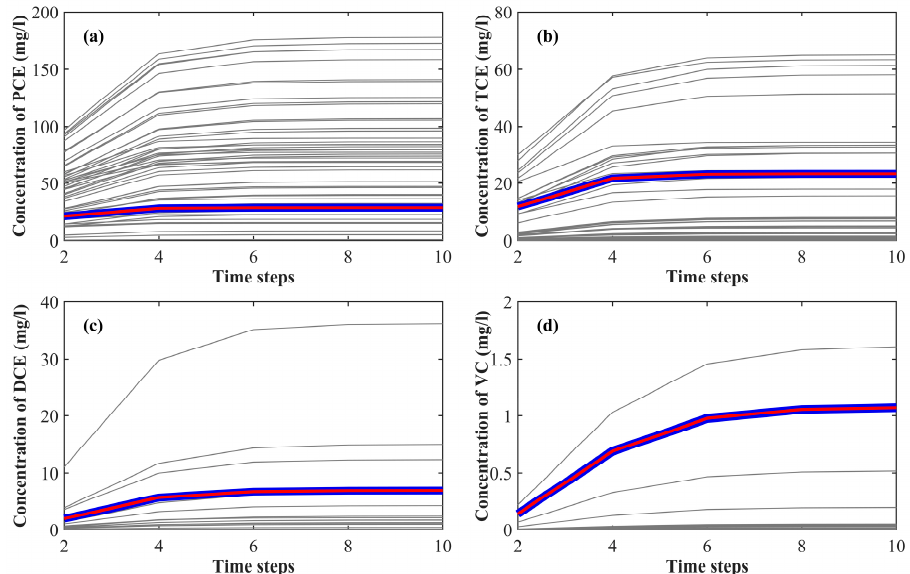
Figure 5. The performance of data match. ( a ), ( b ), ( c ), ( d ) shows the data match of the concentration of tetrachloroethene (PCE), trichloroethene (TCE), dichlorethene (DCE) and vinyl chloride (VC) at the observation well, respectively. The grey lines denote the concentration data which is drawn from the initial ensemble every five samples. The blue lines denote the concentration data of the last ensemble. The red line denotes the true values of the measurements.